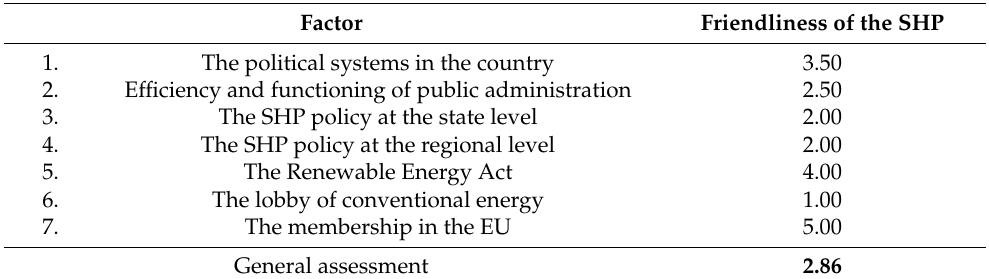
Table 1. The political environment of SHPs in Poland in the context of its development